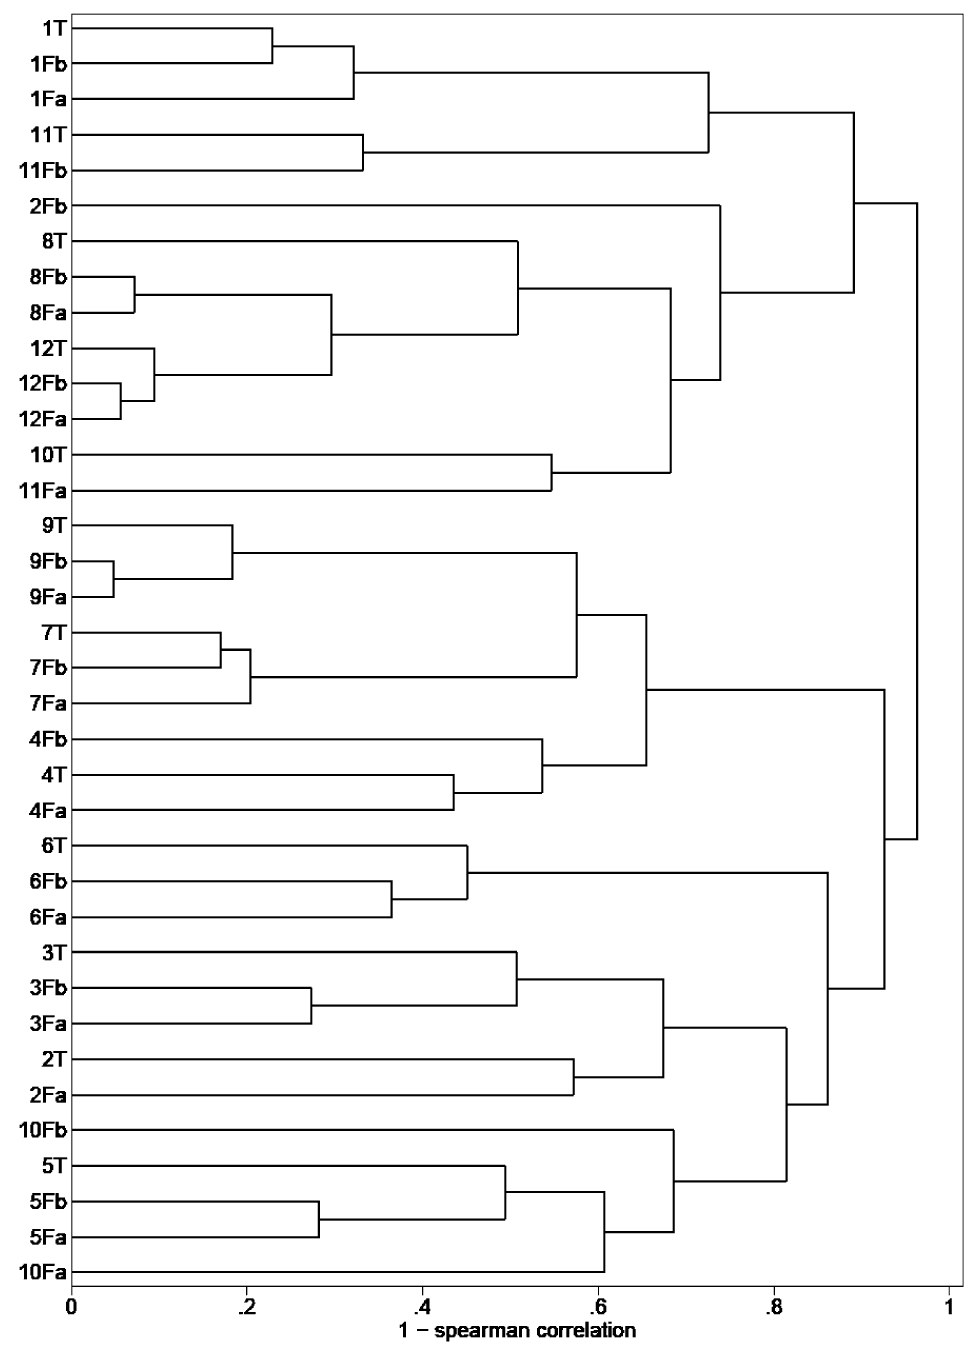
Fig. 4. Cluster analysis of the three samples per patient (FNA-A, -B and tissue biopsy) for each of the 12 patients. Clustering was observed for 9 of 12 patients, whereas only one FNA-sample and the tissue biopsy clustered for patient no. 2 and 11. Fa: FNA-A. Fb: FNA-B. T: tissue biopsy. results depending on the intra-tumor site of